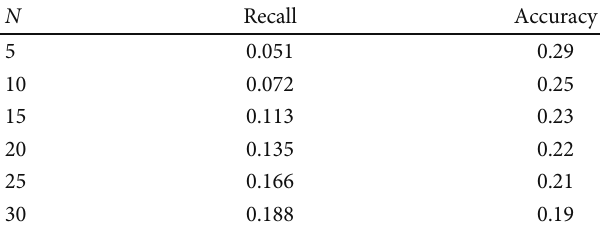
Table 1: Popularity recommendation accuracy and